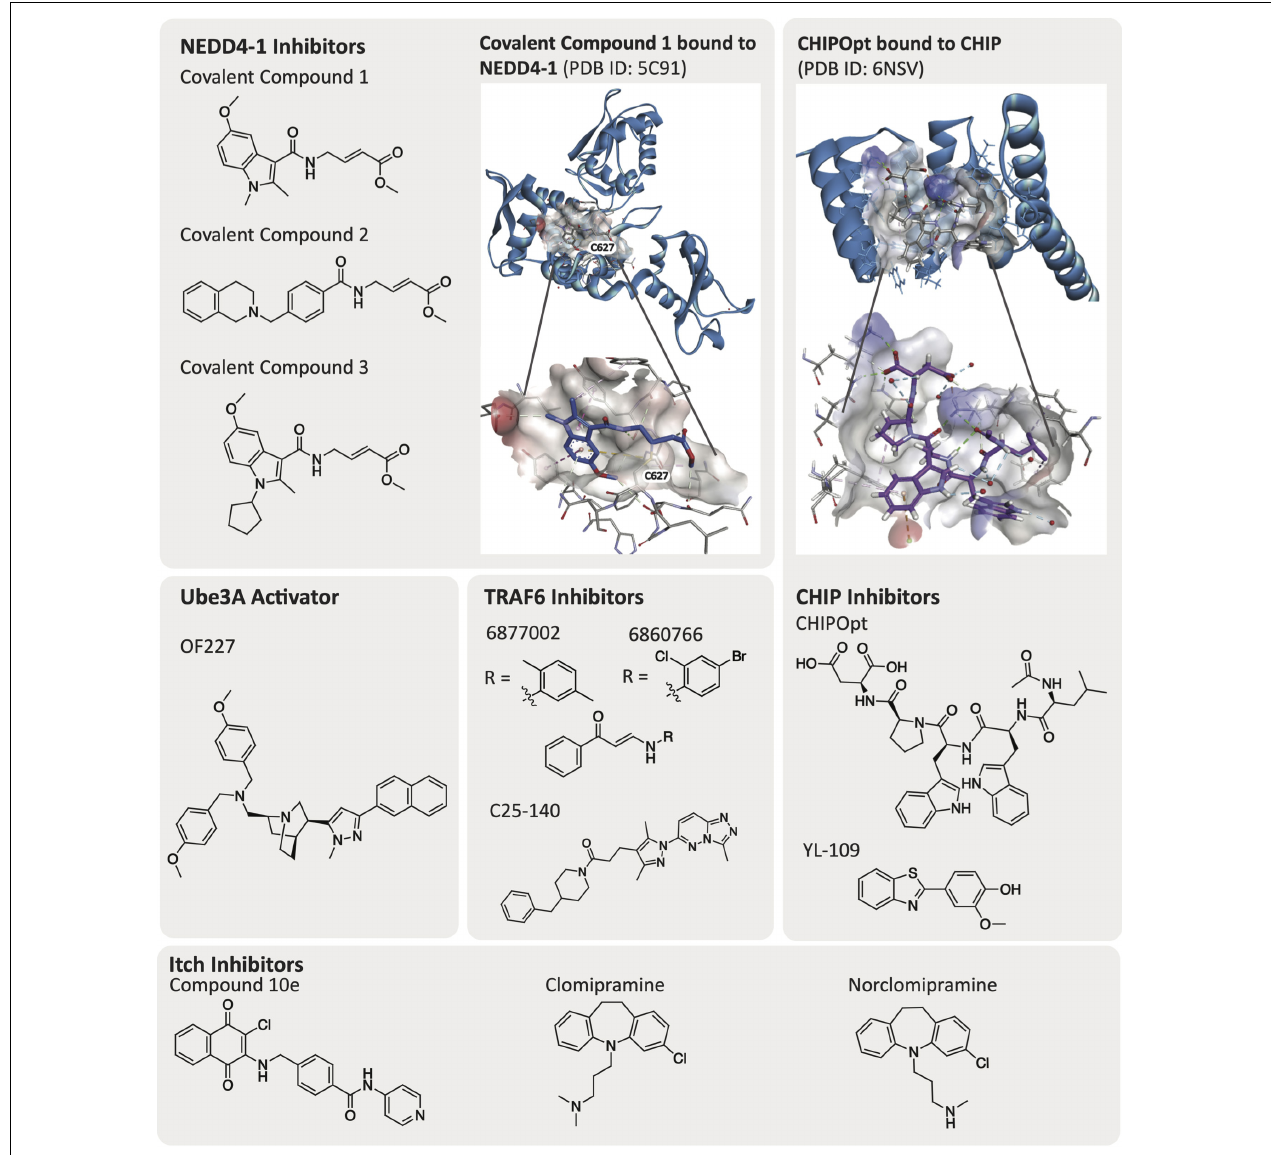
FIGURE 3 | Published E3 ligase modulators and solved ligand-bound co-crystal